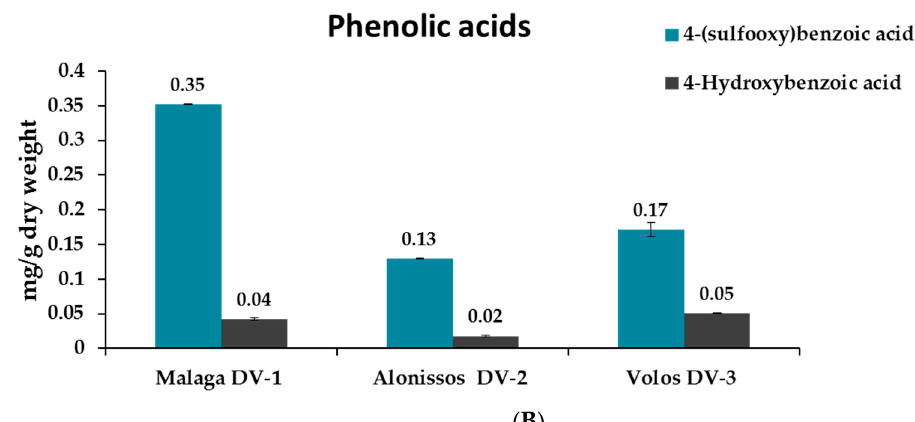
Figure 3. Quantification of the coumarins 1 ) dasycladin A, 2 ) dasycladin B, 3 ) 6,7-dihydroxycoumarin-3-sulfate, 4 ) 3,6,7-trihydroxycoumarin. Concentrations are given as mg coumarins/g dry weight ( A ) and as mg/g phenolic acids as dry weight ( B ) (n = 3) in the green alga Dasycladus vermicularis collected at different sampling sites and dates in the Mediterranean Sea.